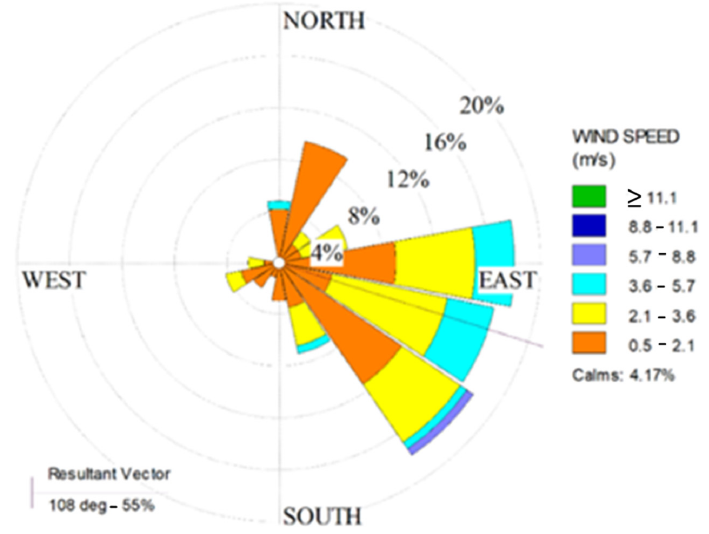
Figure 12. A wind rose profile of the PV power plant’s premises over a